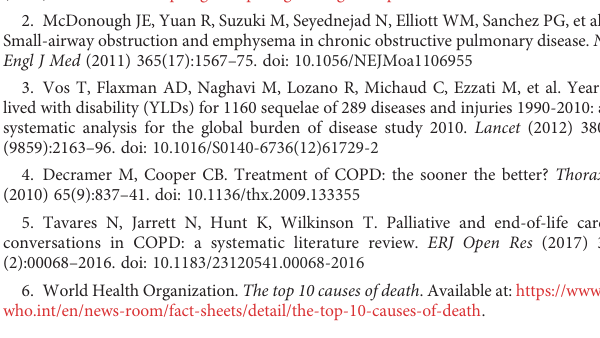
SUPPLEMENTARY FIGURE 1 (A) Enrichment analysis in cell type signatures. (B) Enrichment analysis in the DisGeNET database. (C) Enrichment analysis in the PaGenBase database. (D) The TF-gene regulatory network of DEGs constructed on the basis of the TRRUST database. Red circles represented transcription factors, while blue squares represented DEGs. SUPPLEMENTARY FIGURE 2 (A-C) GO enrichment annotations of genes represented by the MEdarkgrey module in three categories: (A) BP, (B) CC, (C) MF. (D) KEGG pathway enrichment analysis revealing key signaling pathways of genes represented by the MEdarkgrey module. (E) Enrichment analysis in DisGeNET database. (F) The TF-gene regulatory network of genes represented by the MEdarkgrey module constructed on the basis of the TRRUST database. Red circles represented transcription factors, while blue squares represented module genes. SUPPLEMENTARY FIGURE 3 (A) The boxplot showing the differential expression of TNMD and LINC00656 in Cluster1 and Cluster2 subtypes. (B) Correlation of the TNMD expression with clinical characteristics. The histogram for the categorical variable was utilized to depict the distribution of COPD patients in high and low TNMD expression subgroups at the various GOLD stages. The histogram for continuous variables was used to compare differences in age and smoking cigarettes among COPD patients between the two clusters. (C, D) The lollipop charts showing the correlation between the (C) TNMD and (D) LINC00656 expression and in fi ltrating immune cells. SUPPLEMENTARY FIGURE 4 The transcript levels of TNMD and LINC00656 in (A, B) HBE and (C, D) A549 cells treated with various CSE concentrations (1%, 2%, 3%) for 48 hours were measured by quantitative real-time PCR (qRT-PCR) analysis. Data were presented as the mean ± SD of three independent